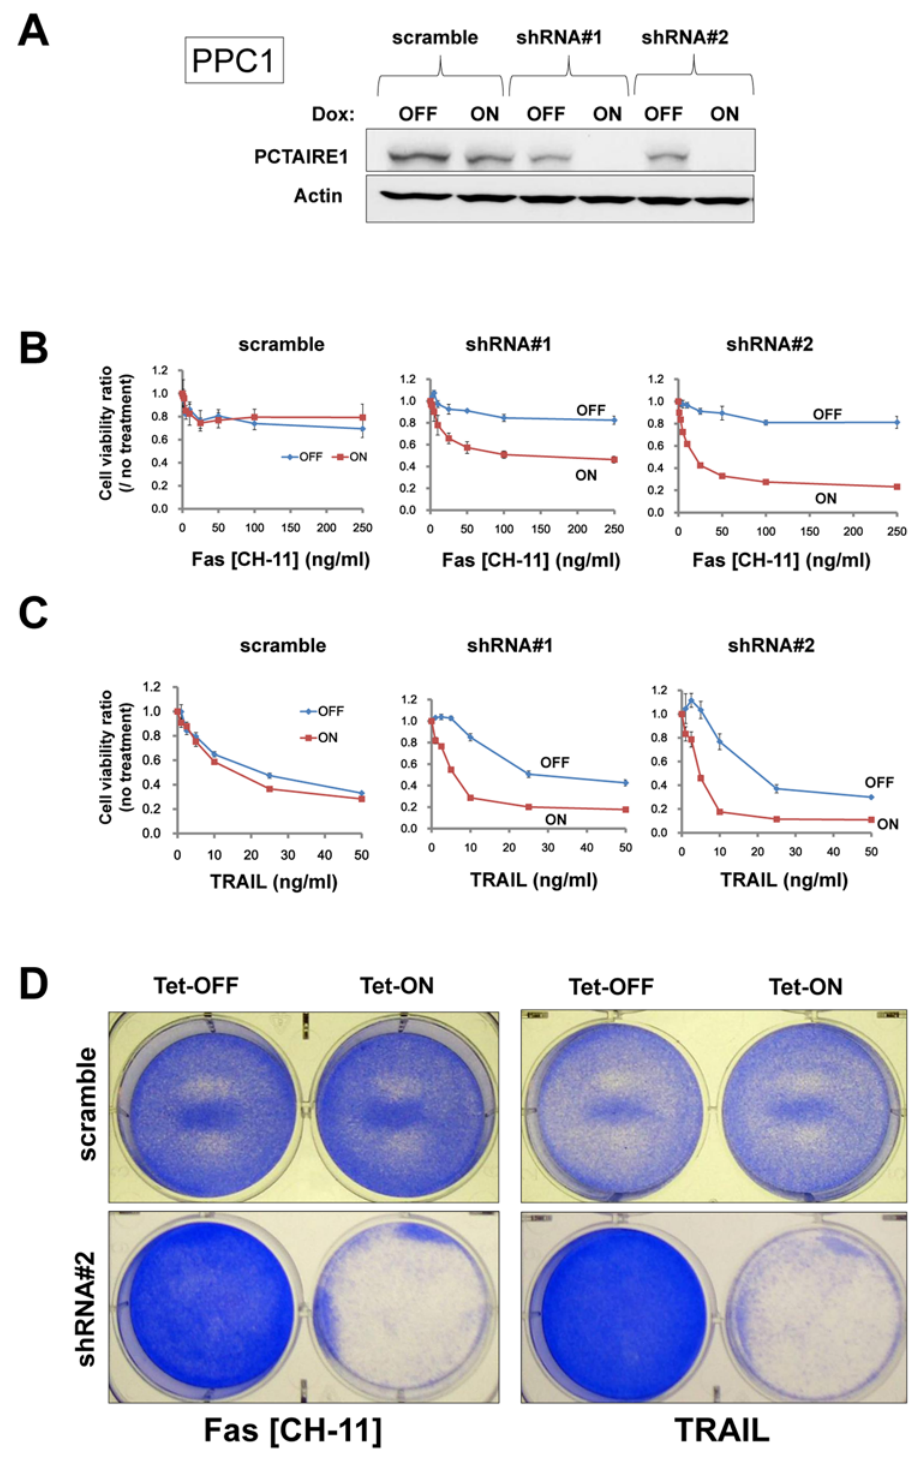
Fig 2. Targeting PCTAIRE1 using an inducible shRNA vector in PPC1 cells. (A) PPC1 cells stably containing inducible shRNAs targeting different sites on PCTAIRE1 mRNA (shRNA#1, #2) or scramble- control were cultured for 48 hours with doxycycline (Dox, 100 ng/ml). Protein lysates were generated, normalized for total protein concentration, and analyzed by SDS-PAGE/immunoblotting using antibodies for PCTAIRE1 (top) and beta-actin (bottom). (B, C) PPC1 cells were cultured with (ON) or without (OFF) 100 ng/